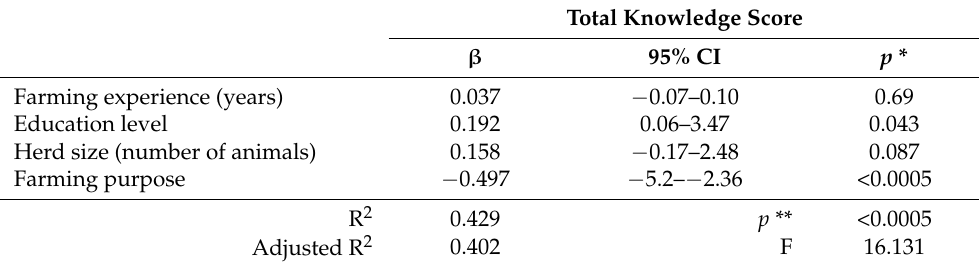
Table 4. Determinants of farmers’ knowledge for safety manure